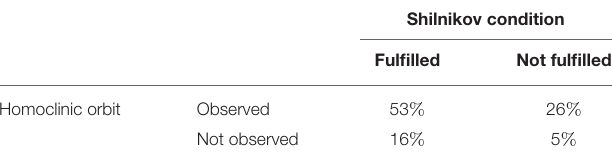
TABLE 2 | Four-fold table evalutating Shilnikov condition and homoclinic orbit in data epochs well-described by the assumed model.